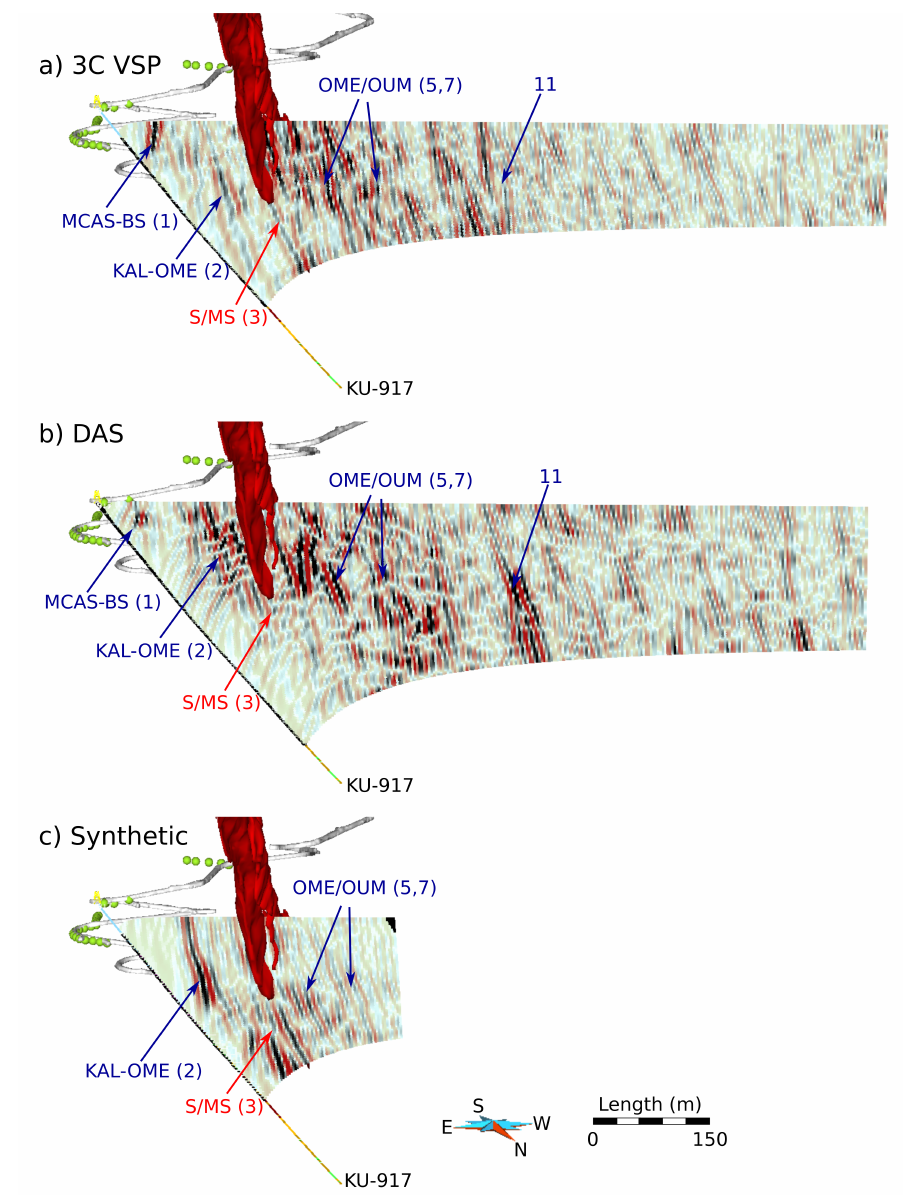
Figure 9. Comparison between conventional geophone ( a ) and DAS VSP ( b ) migrated images from acquired data and from synthetic VSP data ( c ) as viewed from north to south. The synthetic image is limited towards the west, due to the lack of geological information in that area. Blue labels denote interpreted rock contrasts. The reflector numbering is explained in the next section (Table 4). Seismic sources are indicated by green spheres in the mine